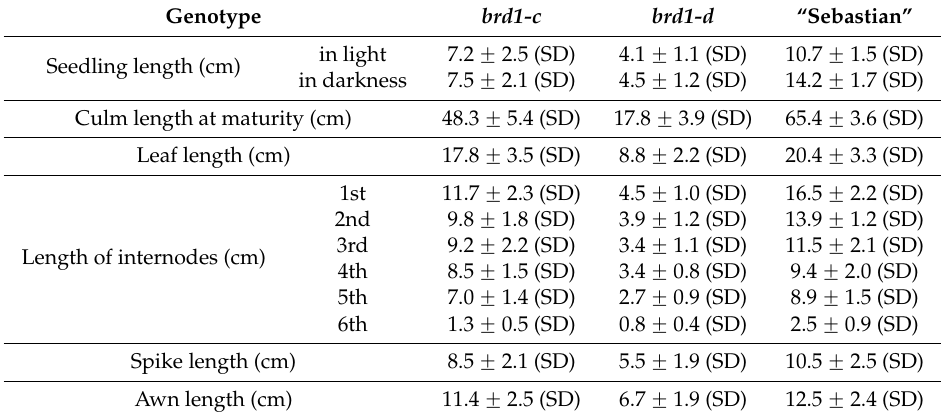
Table 2. Phenotypic characteristics of the homozygous mutants with the brd1-c and brd1-d alleles and the parent variety “Sebastian”. The mean values and standard deviations (SD) are presented. Ten plants per genotype at mature stage of the development were